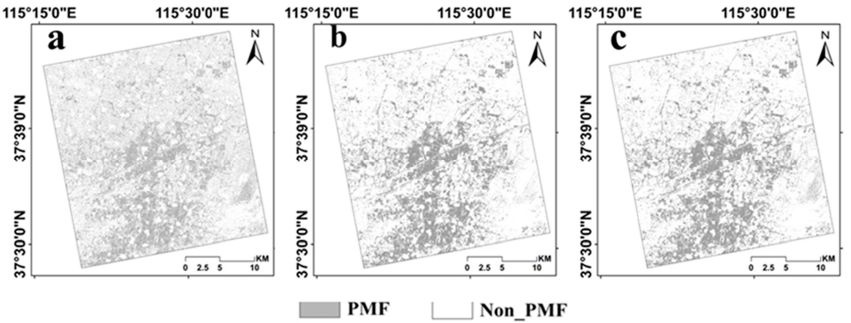
Figure 8. The spatial distribution of PMF in Jizhou (( a ) result from RF using backscattering intensity of four polarizations, ( b ) result from RF using all features, ( c ) result from SVM using all features).